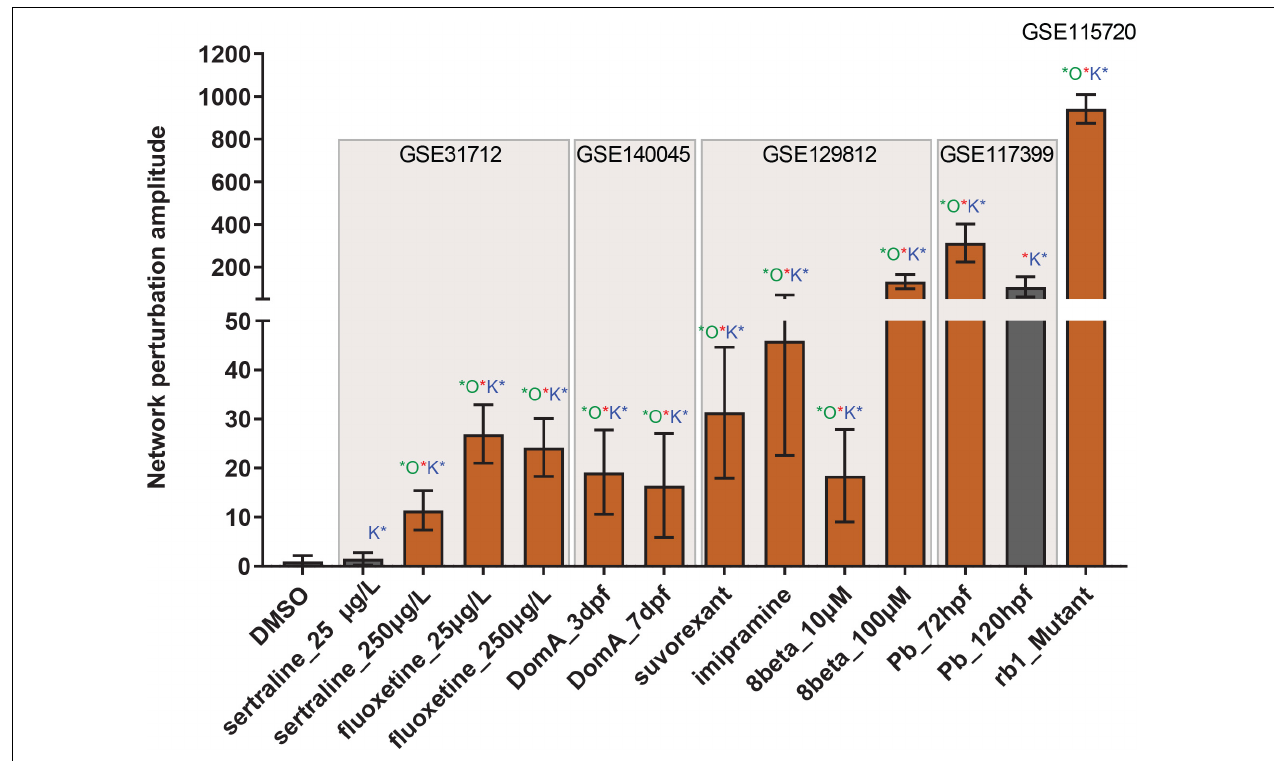
FIGURE 3 | Neurotoxicity network perturbation amplitude (NPA). NPA values are shown as fold change over DMSO control with proportional adjustment of confidence intervals. Beige rectangles highlight separate transcriptomic datasets. Red stars indicate significant NPA values. Green stars indicate significant o statistic values — a measure of how specific the given perturbation is to the current network. Blue stars indicate significant o statistic values — a measure of the quality of the functional layer. Orange bars indicate significant perturbation, while gray bars represent values where at least one statistic was not significant.